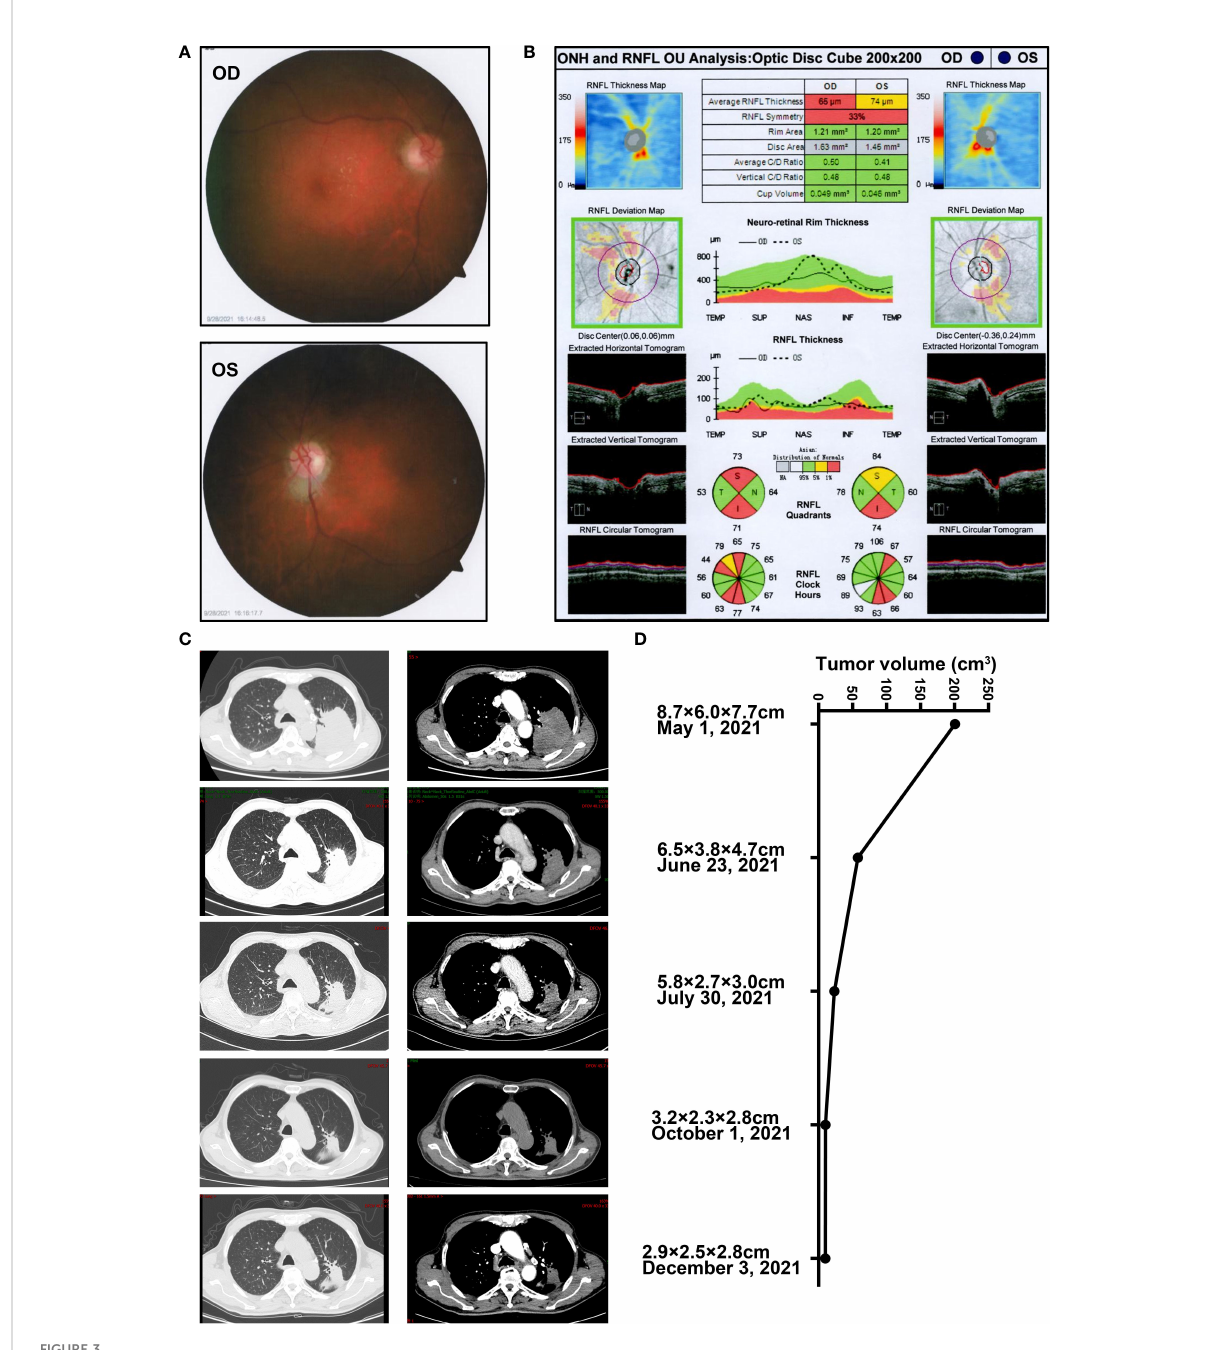
FIGURE 3 The ophthalmic examination of the patients post steroids against sintilimab-induced optic neuropathy and representative CT images in the follow-up (A) Fundus photography post steroids against optic neuropathy secondary to sintilimab therapy on 28 September 2021. (B) OCT examination of the optic disc post steroids against sintilimab-induced optic neuropathy on 28 September 2021. (C) Representative CT images and (D) the estimated tumor volume during the treatment of the case in the follow-up from 1 May 2021, to 3 December 2021. The horizontal axis represents changes in tumor volume. The vertical axis depicted the time of CT scan and the estimated tumor longitudinal diameter (X) and the greatest transverse diameter (Y) in the axial plane and the maximum thickness in head-to-foot direction (Z). The tumor volume was calculated by using the formula